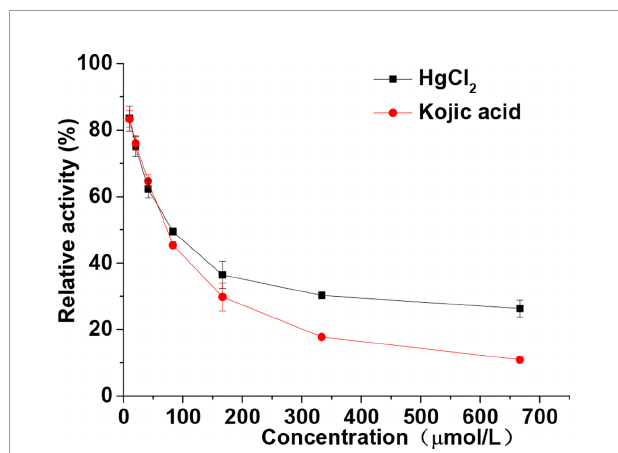
FIGURE 2 | Relative activity of tyrosinase through diphenolase reactions with dopa in the presence of various concentrations (from 10.42 – 666.67 m mol/L) of HgCl 2 and kojic acid. The fi nal concentrations of dopa were 0.5 mmol/L. Data are presented as mean ± standard deviation (n =